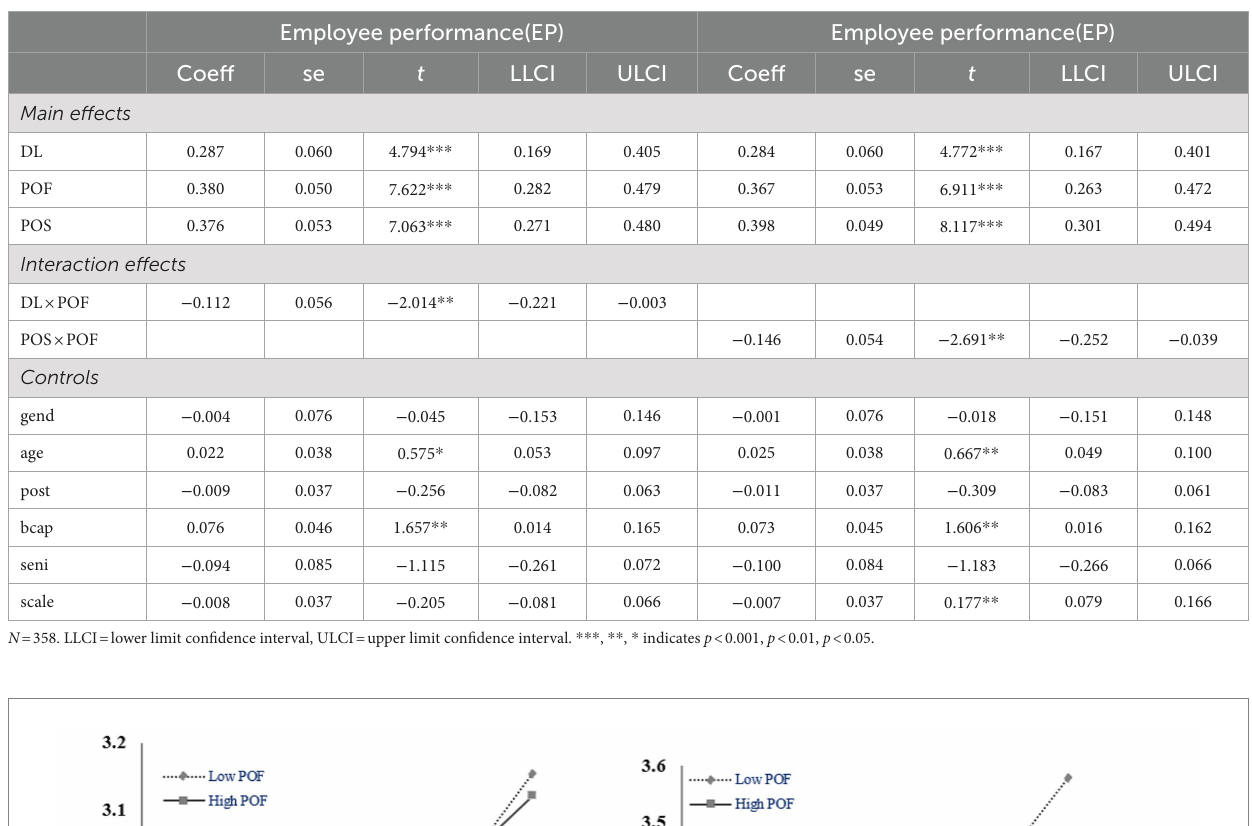
TABLE 4 Bootstrapping results for moderated mediating effect.